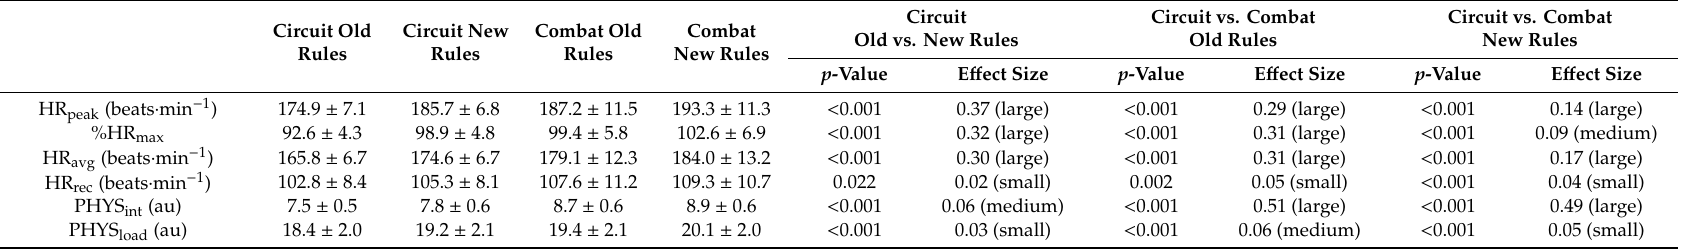
Table 2. Heart rate and relative physiological intensity / load during taekwondo-specific circuit training and combat—comparison between old and new rules. Circuit New Circuit Old Rules Rules